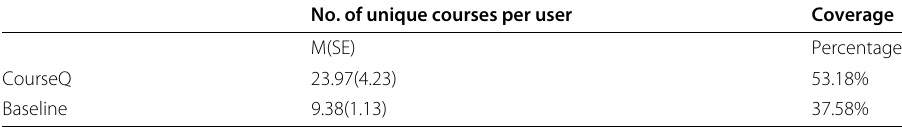
Table 2 Number of unique courses per user and overall